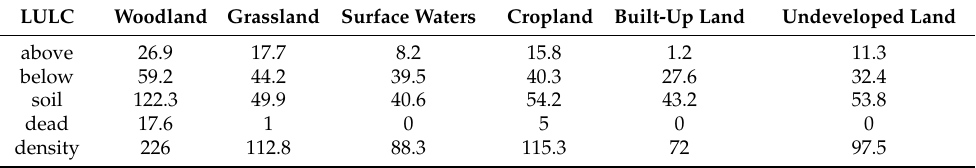
Table 1. Carbon storage per unit area of each LULC type [30] (Unit: ton/ha). LULC Woodland Grassland Surface Waters Cropland Built-Up